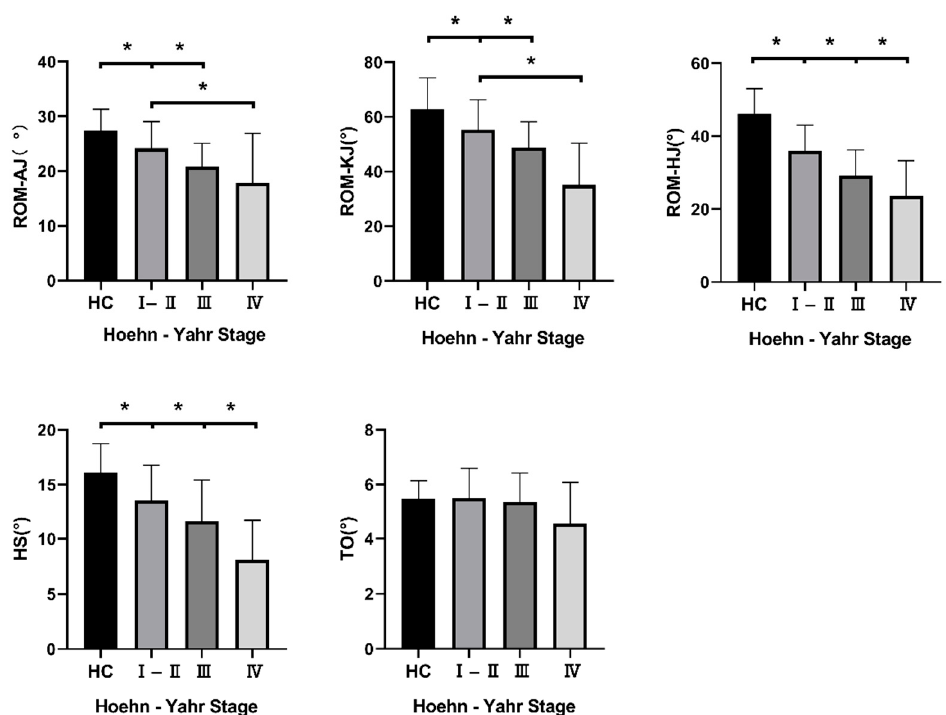
Figure 3. Kinematic gait parameters of participants. Note: Value is listed as mean ± SD; * p < 0.05.